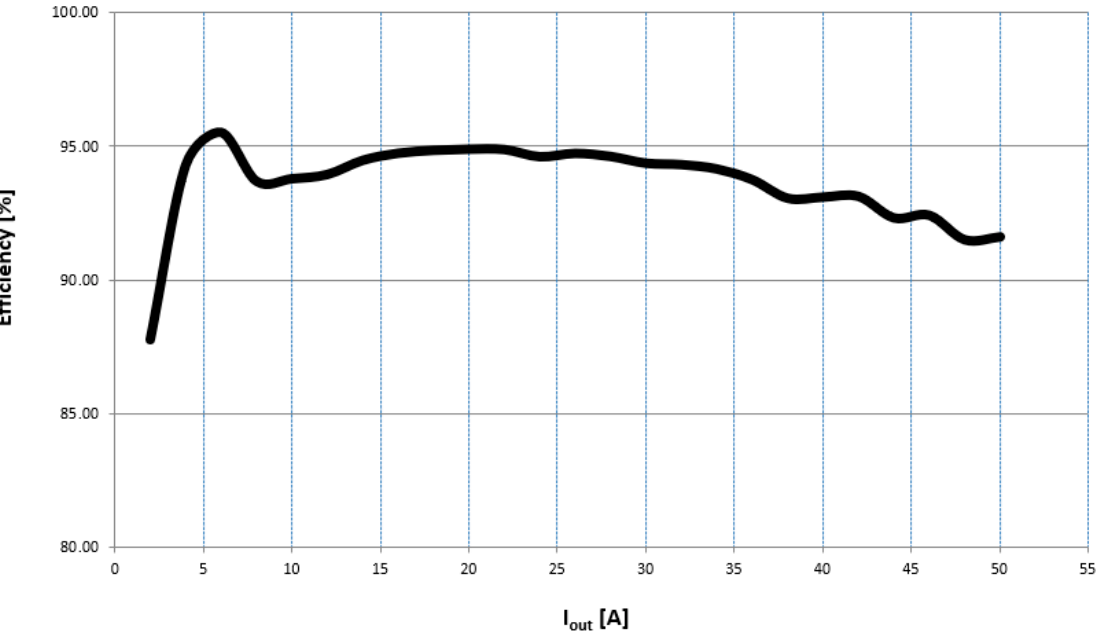
Figure 6. Main switching waveforms at 20 A load.